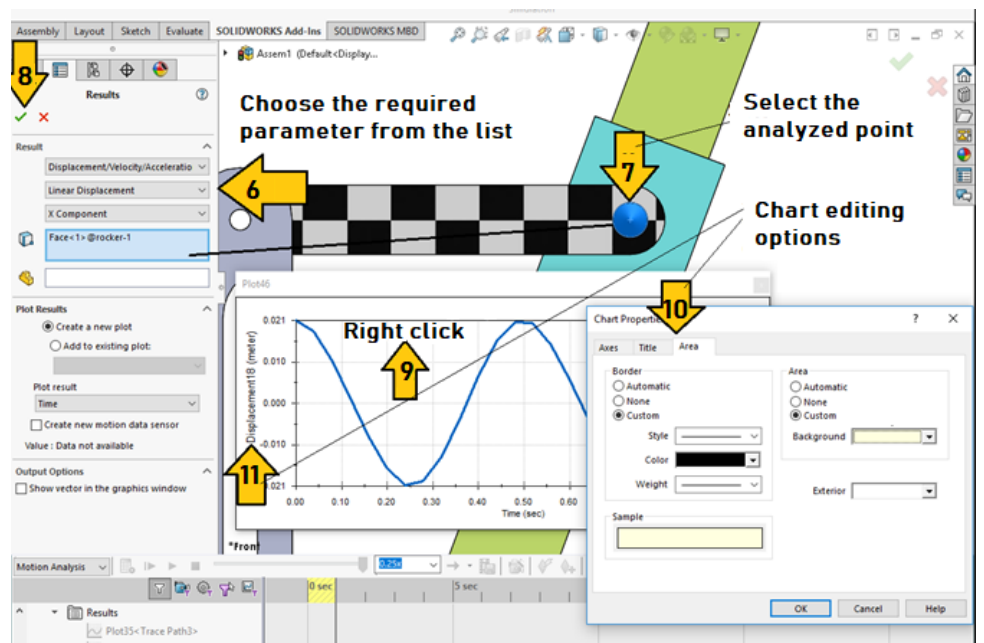
Figure 7. Chart plotting